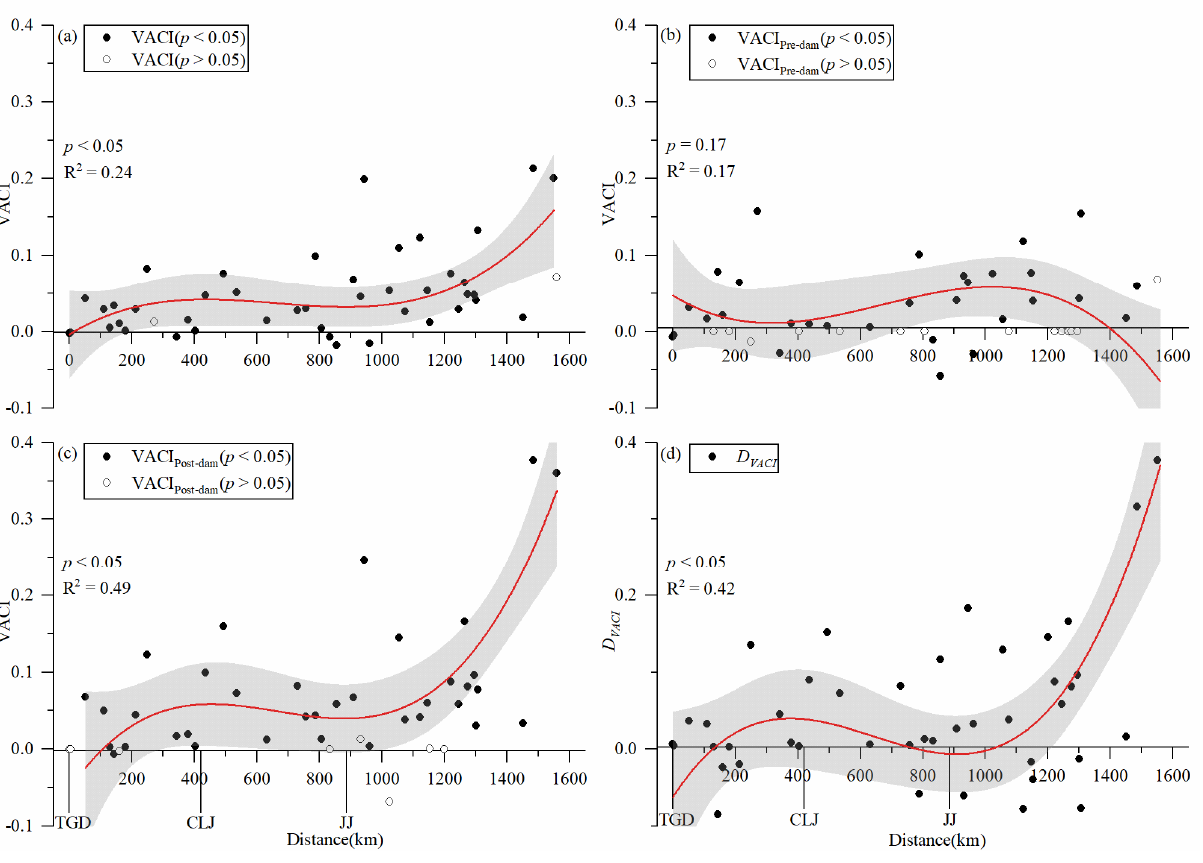
Figure 6. Relationships between VACIs of individual MCBs and distance from MCB to the dam in the three distinct periods. ( a ) For whole period: 1987–2017; ( b ) for pre-dam period: 1987–2002; and ( c ) for post-dam period: 2003–2017. ( d ) For the difference of VACIs in post- and pre-dam period. The shaded areas are 95% confidence intervals.